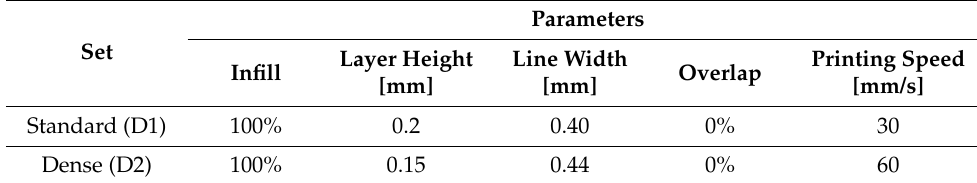
Figure 2. Schematic of the creep samples: ( a ) Geometry; ( b ) creep sample infills in the slicing software by Desktop Metal. Table 2. Samples and printing parameters used in the present study.